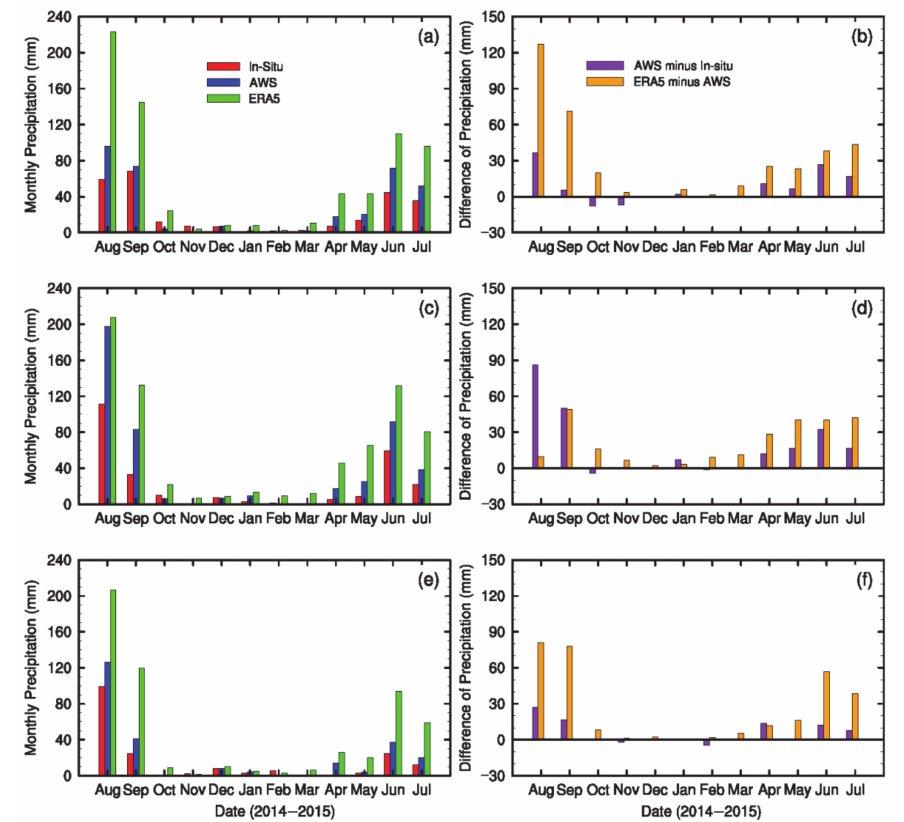
Figure 3. Comparison of monthly total precipitation and the di ff erence between di ff erent datasets at the ( a , b ) Amdo site, ( c , d ) Nagqu site, and ( e , f ) Baingoin site (AWS minus insitu: the di ff erence between AWS and in situ precipitation; ERA5 minus AWS: the di ff erence between ERA5 and AWS precipitation). The land cover types are set to grassland at the three sites in Noah-MP LSM. The MODIS (MOD15A2) 8-day composite LAI data at a 1 km resolution (Oak Ridge National Laboratory Distributed